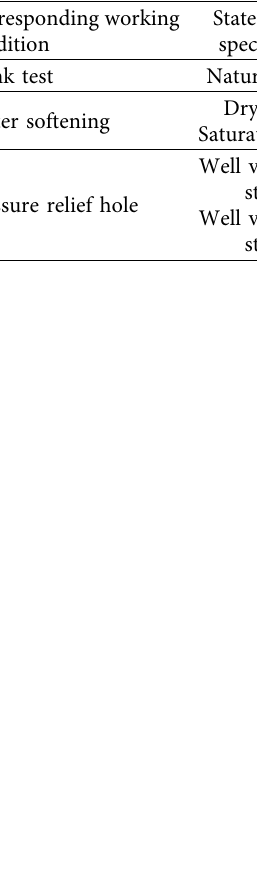
Figure 4: Stress-strain curves of rock samples in different water-bearing